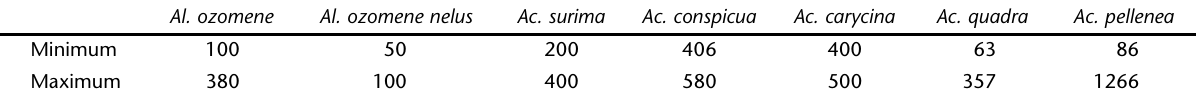
Table III. Number of eggs per clutch in Altinote ozomene (this study) and other Acraeini (D EVRIES 1987, P ALUCH et al. 1999, 2001, F REITAS et al. 2009a, b, 2010, and F RANCINI & F REITAS 2010).